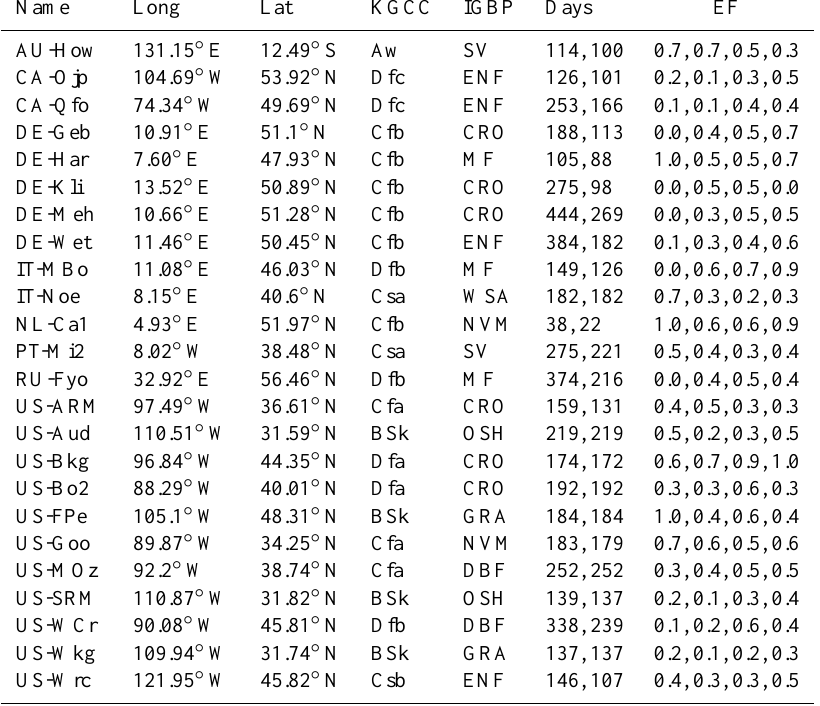
Table 2. Stations selected to run the models with tower inputs. From left to right: station name; longitude; latitude; Köppen–Geiger Climate Classification (KGCC); International Geosphere–Biosphere International Programme (IGBP) land cover; total number of days with data, no precipitation number of days with data; evaporative fraction (EF) for the DJF, MAM, JJA, SON 3-month